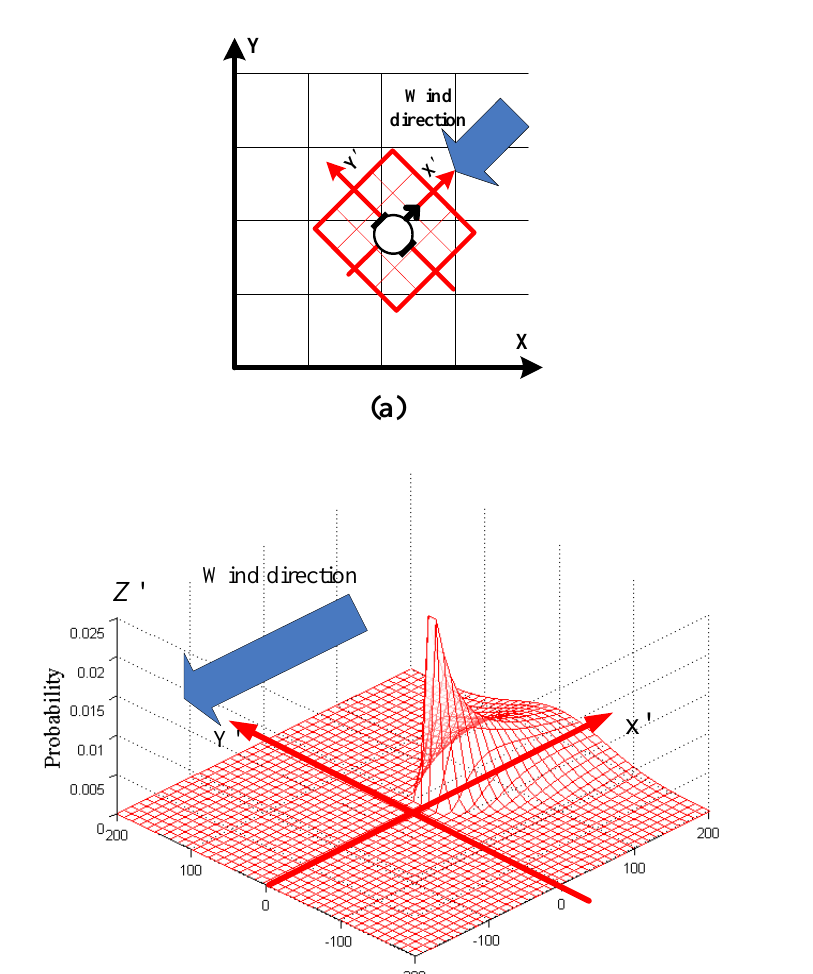
Figure 4. (a) The grids in the robot and world coordinate systems; (b) Separate gas source probability distribution map (the gas is detected); (c) Separate gas source probability distribution map (the gas is